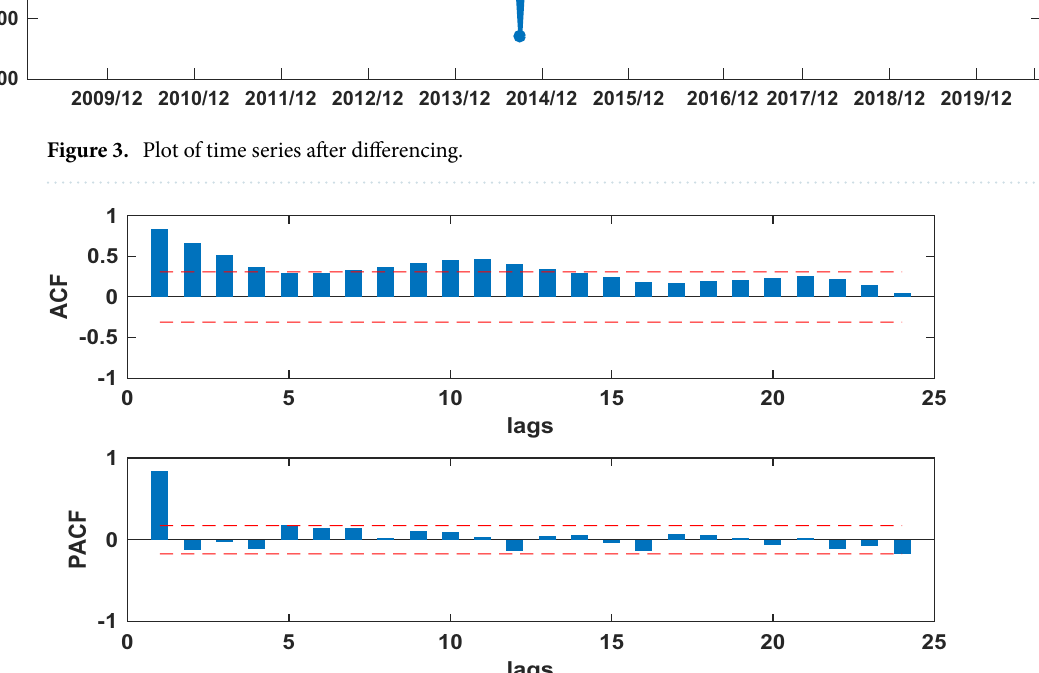
Figure 4. The ACF and PACF of time series after differencing of human brucellosis cases in Xinjiang.